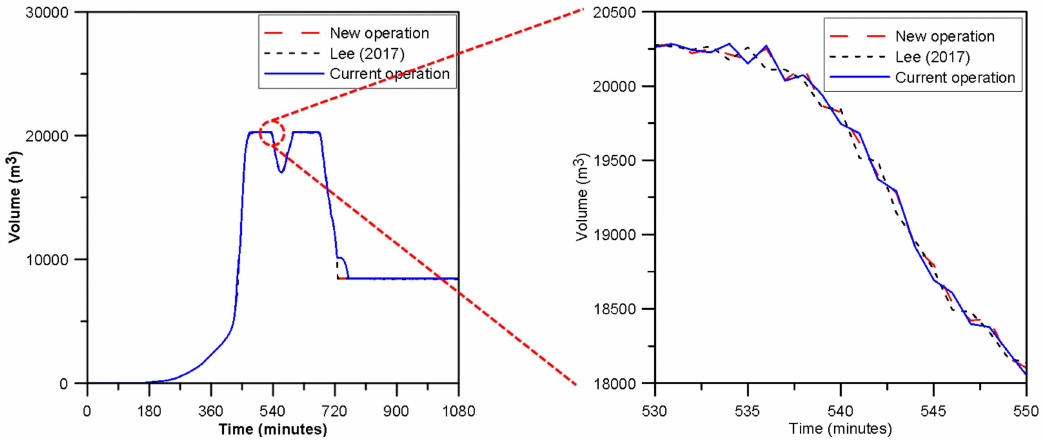
Figure 10. Volume of the centralized reservoir in 2010 [1].